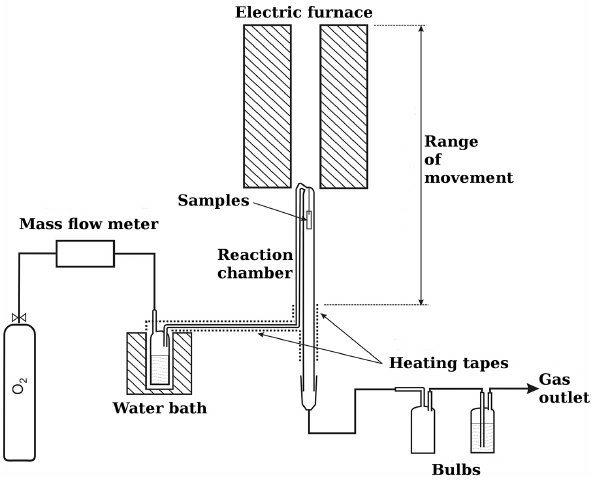
Figure 1: Scheme of the apparatus for oxidation test of metals in an atmosphere containing steam under thermal shocks